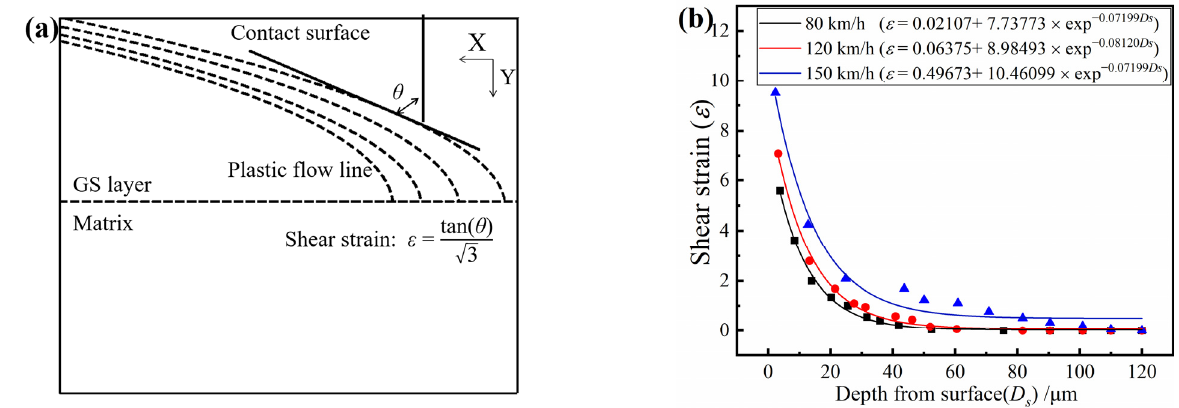
Figure 8. ( a ) Schematic of the shear strain and ( b ) curves of shear strain along with the depth. According to Equations (5) and (6), the distribution of the shear strain along the depth